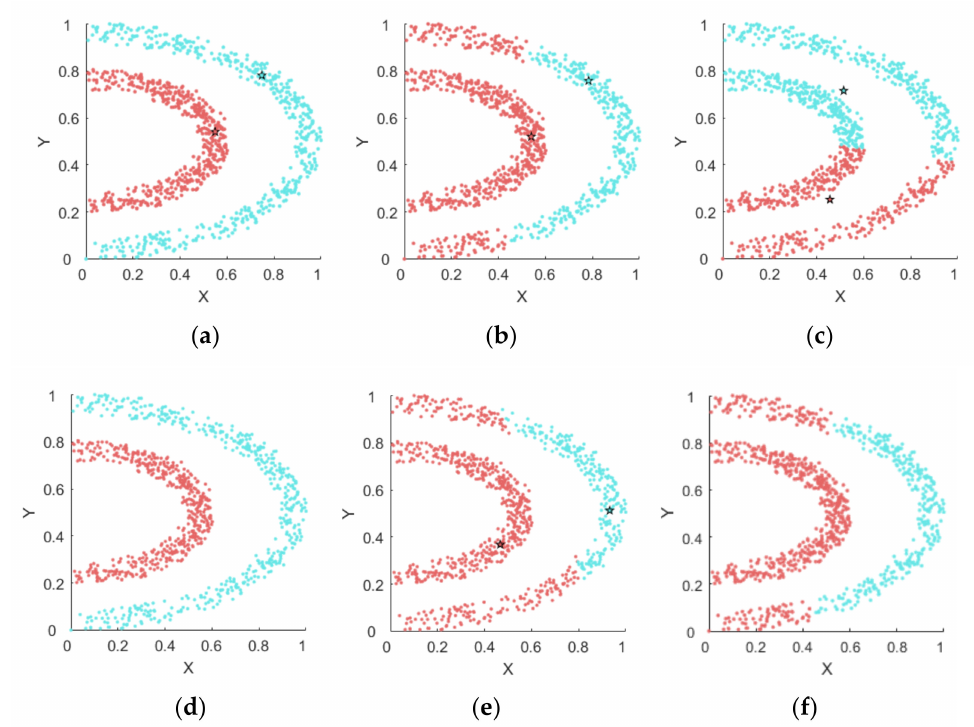
Figure 8. Results on HalfKernal. ( a ) ConDPC, ( b ) DPC, ( c ) K-means, ( d ) DBSCAN, ( e ) DPC-DBFN,